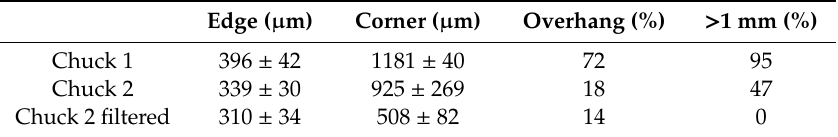
Table 1. Summary of the edge bead measurements, showing the edge bead width, corner bead width, percentage of corner beads overhanging the chip corner, and percentage of corner beads larger than 1 mm. Edge and corner lengths are given as the average and 95% error bound calculated using a Student’s T distribution. Four samples were used to test each of the